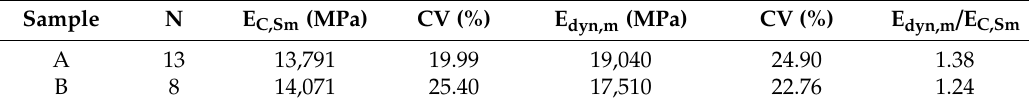
Table 4. Static and dynamic modulus of elasticity from compression and ultrasonic tests.